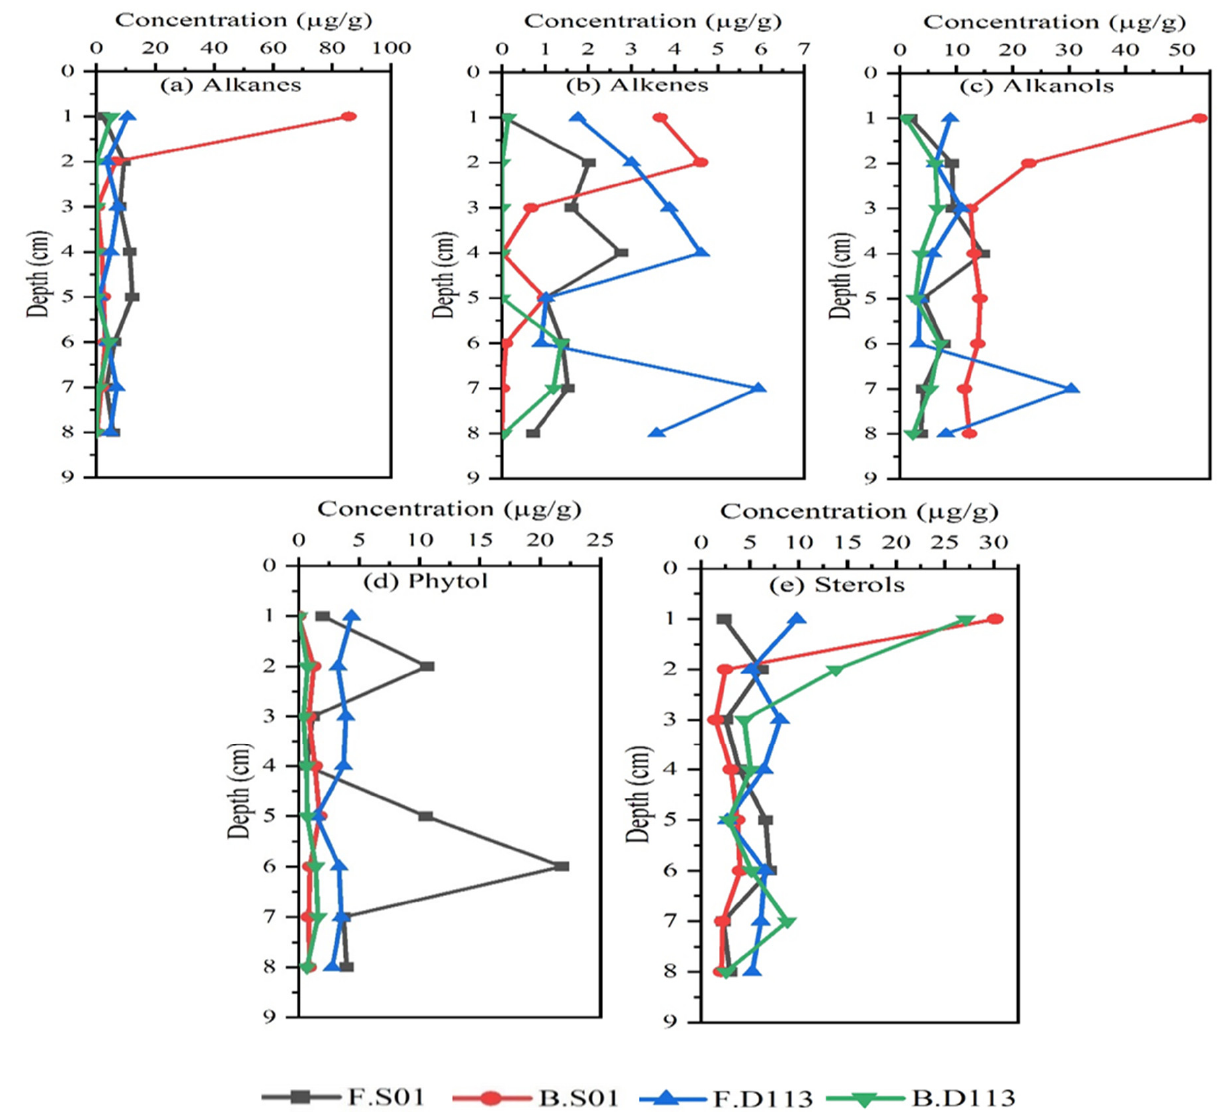
Figure 6. Vertical distribution profiles of neutral lipids in total concentrations. Where F.S01 and F.D113 represent free neutral lipids and B.S01 and B.D113 represent bound neutral lipids in the two sediment samples. Panel ( a ) shows the total concentrations of alkanes, panel ( b ) shows the concen- trations of alkenes, panel ( c ) shows the total concentrations of alkanols, panel ( d ) shows the concen- tration of phytol, and panel ( e ) shows the total concentrations of sterols .